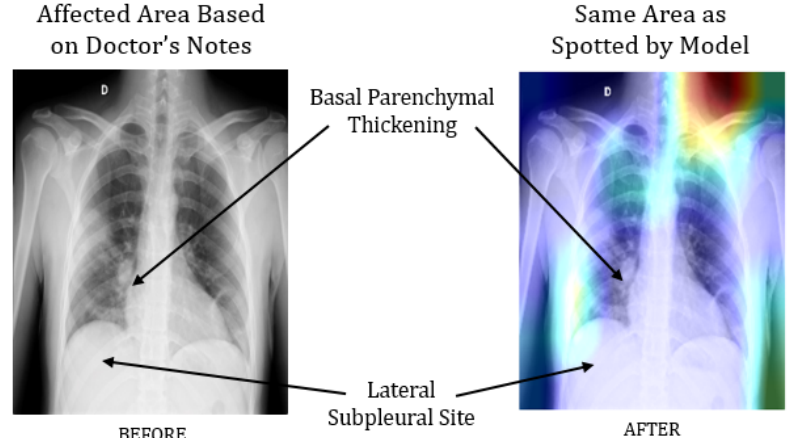
Figure 1. Comparison between a chest X-ray image analyzed by a doctor and a modified VGG16 model, wherein its layer “Block_4” drew particular attention to the collarbone and upper shoul- der [14].